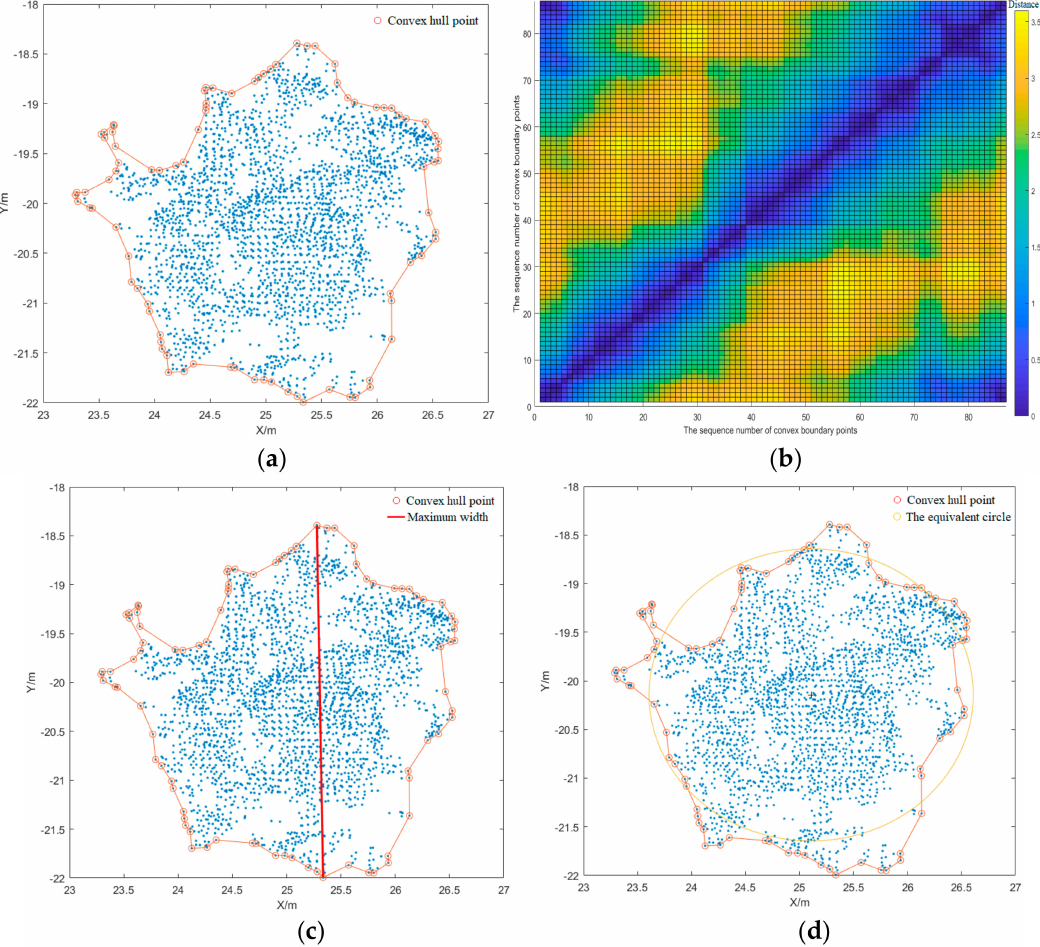
Figure 6. Morphological calculation of the fruit canopy projection on the XOY plane. ( a ) XOY convex hull boundary; ( b ) Distance set of the boundary points; ( c ) Canopy width; ( d ) Equivalent circle of the canopy